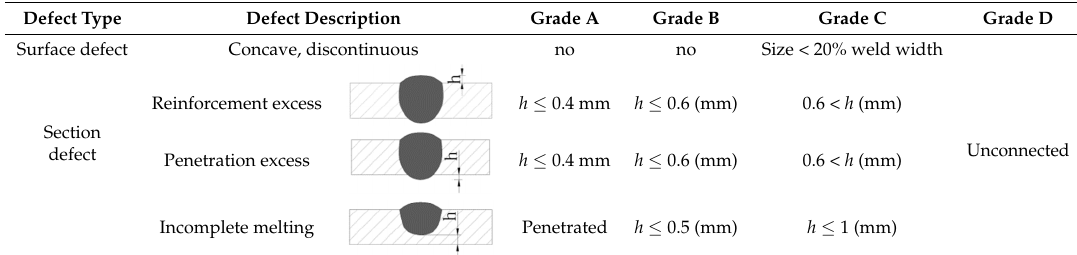
Table 4. Evaluation standard for welding quality of aluminum alloy.